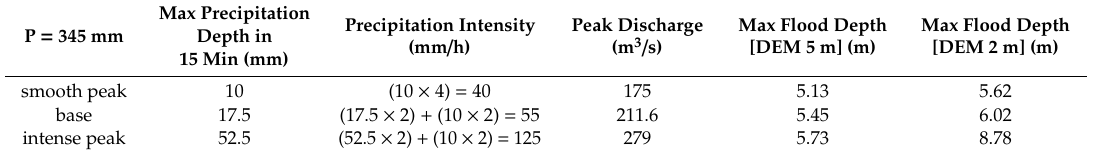
Table 3. Maximum flood depth (m) at high resolution DEMs (5 and 2 m) resulting from di ff erent distributions of peak precipitation for a total amount of precipitated water equal to 345 mm.